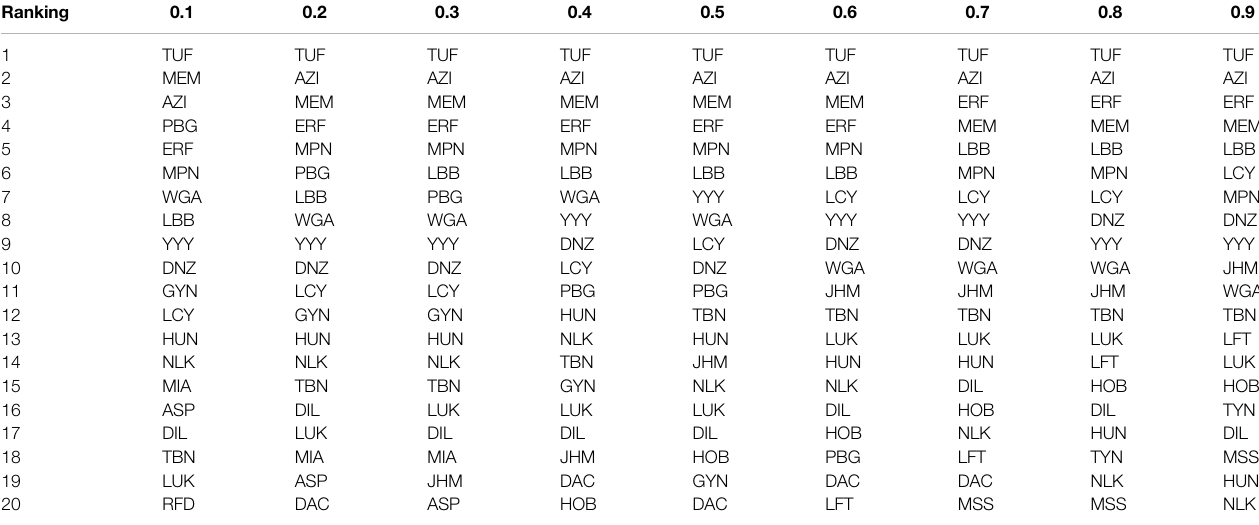
TABLE 3 | Ranking of airport importance by different α (top 20).